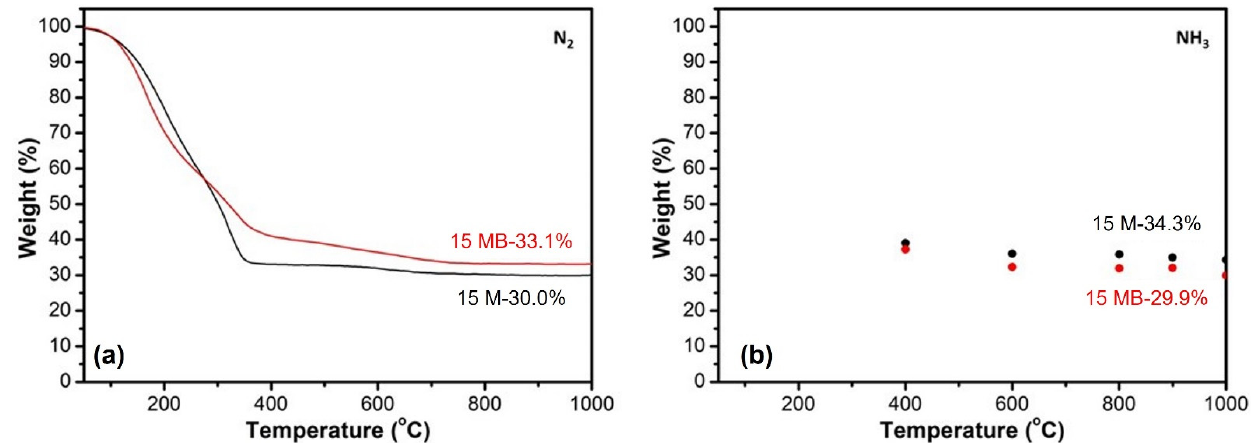
Figure 4. Thermal analyses and ammonia cracking yield of 15 M and 15 MB: ( a ) TGA in N 2 ; ( b ) ammonia cracking yield.